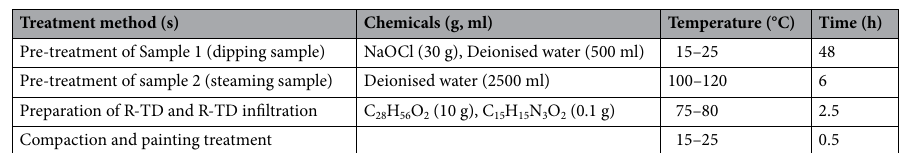
Table 4. The chemical formula and method of preparation of